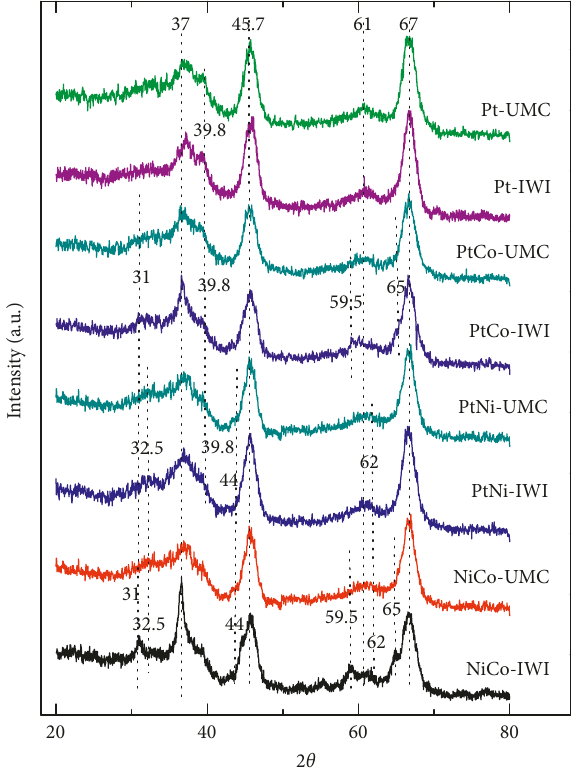
Figure 1: X-ray diffractograms of the studied